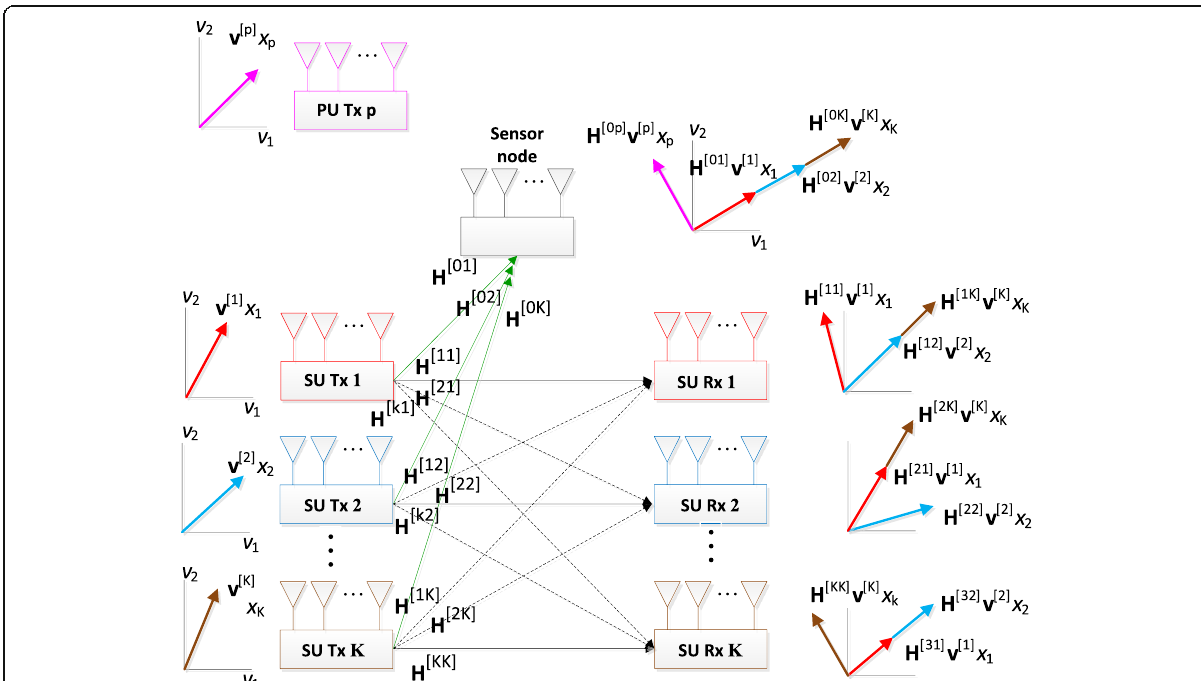
Fig. 4 Interference alignment in sensor. In the proposed system, the SU transceiver pair behaves like a normal interference alignment, but added sensor node removes the transmission signals of other SUs in the interference space. Therefore, the signal of the PU can be sensed in the remaining signal space of the sensor